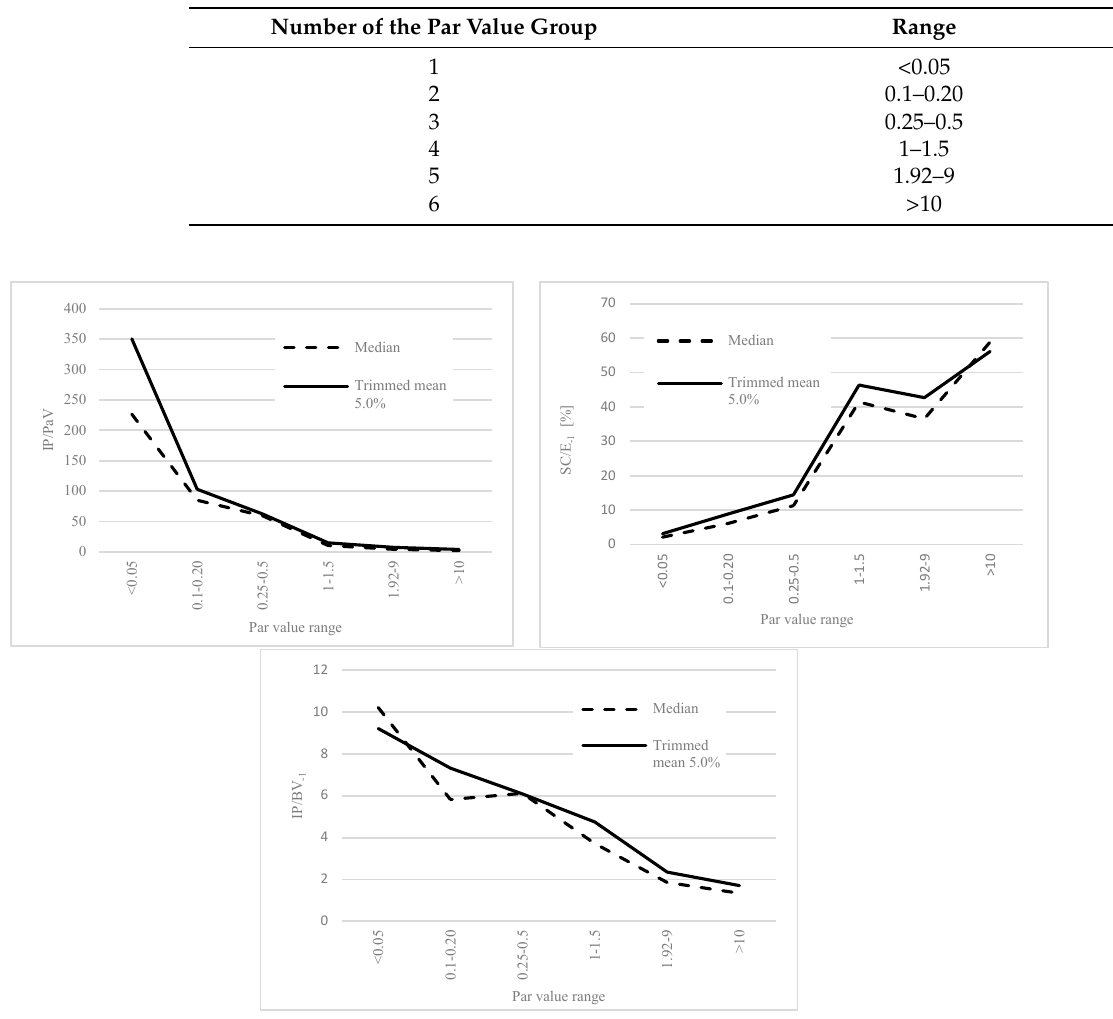
Figure 4. Second-degree financing parameters depending on PaV. Table 9. Regression analysis of the determinants of second-degree financing parameters.